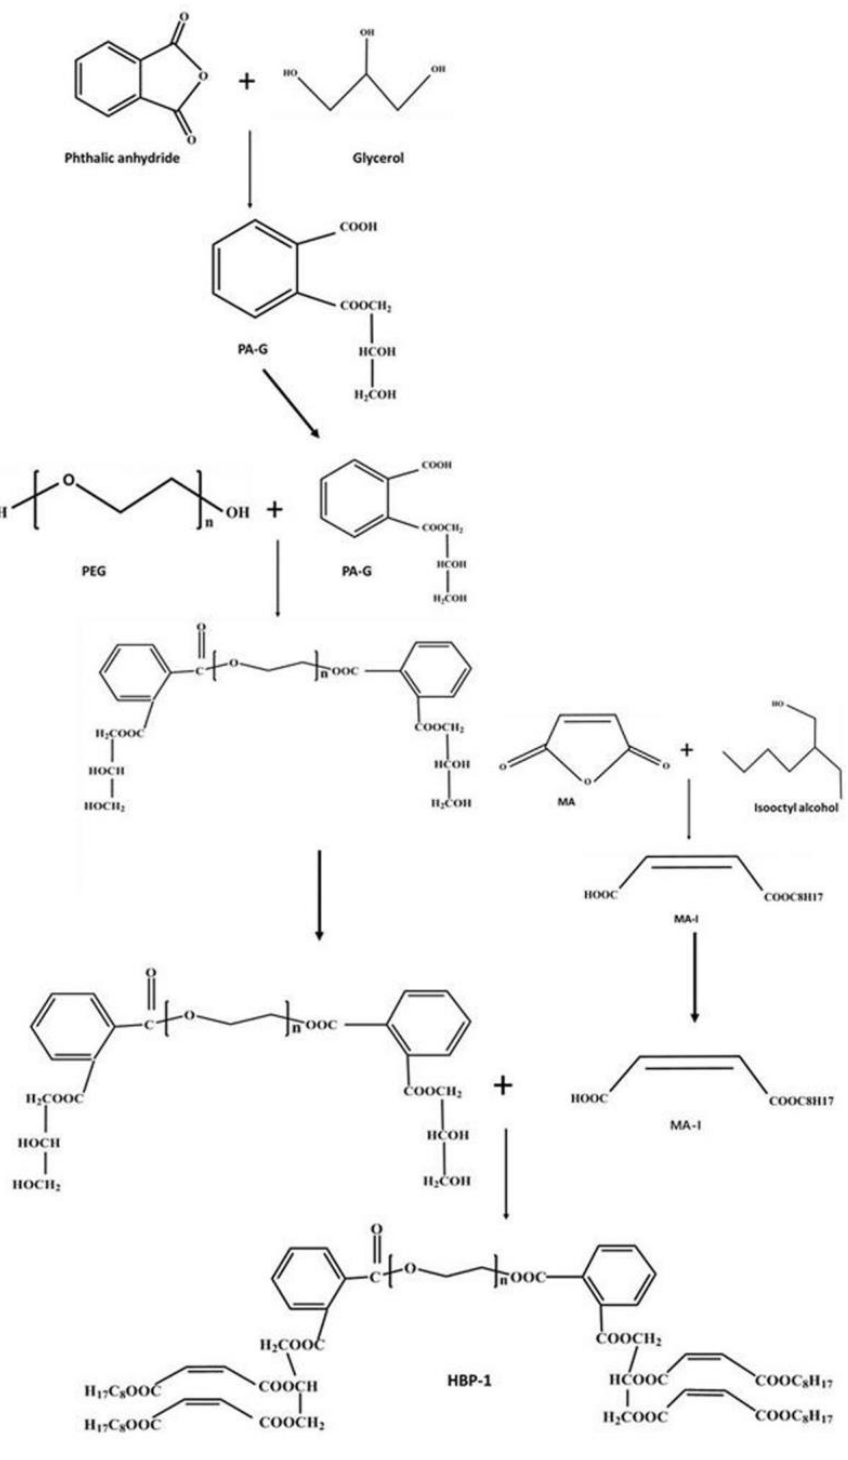
Figure 1. The preparation process of HBP-1.